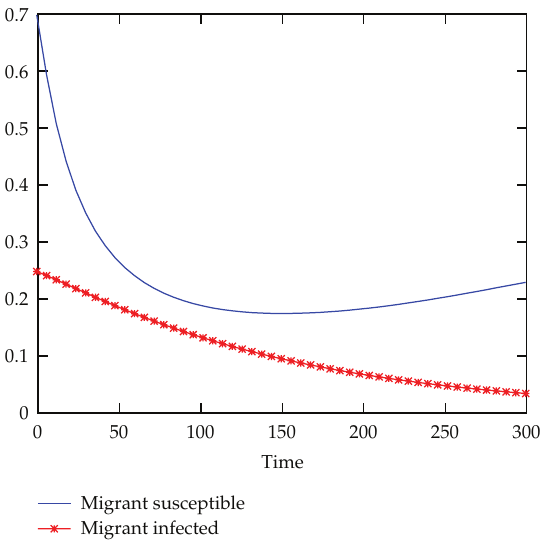
Figure 3: For the case of Example 4.2, we show the proportions of susceptible and infected individuals in the migrant